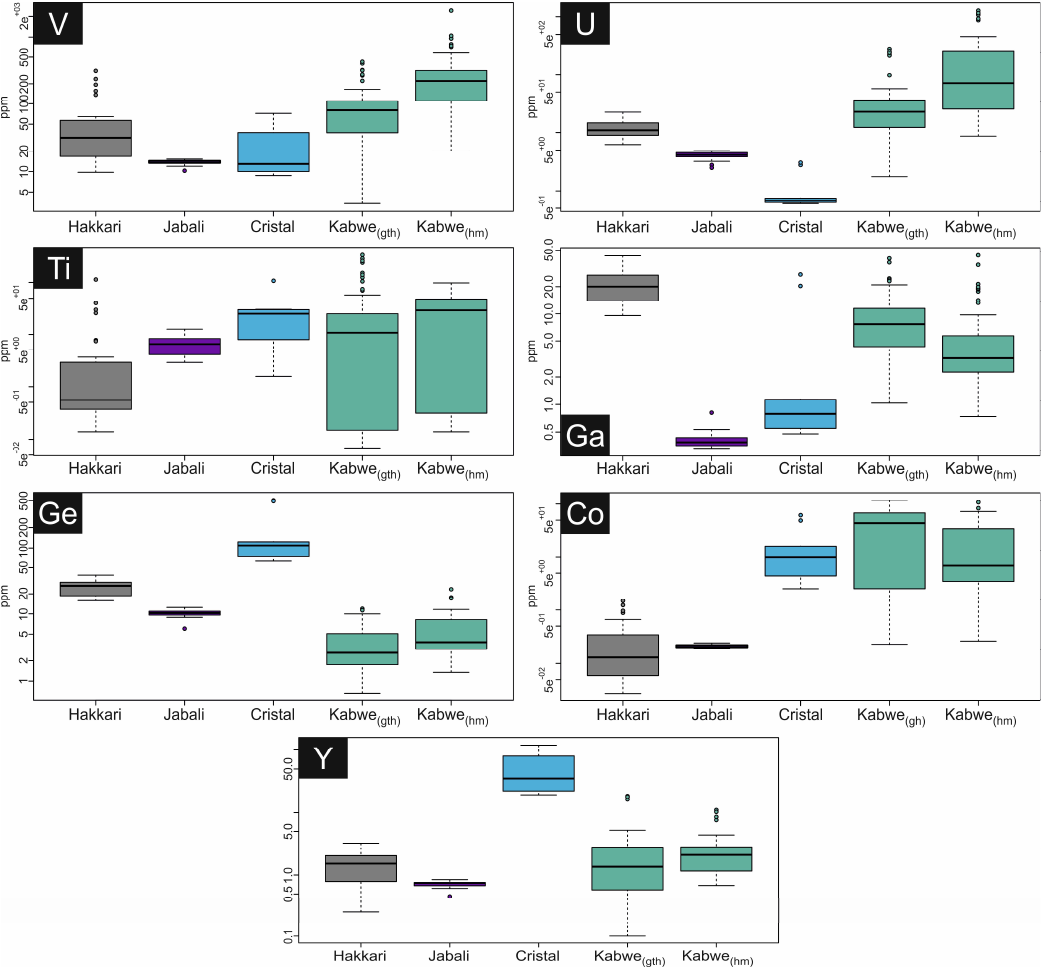
Figure 4. Box and whisker plots showing the chemical composition of the considered FeO/OH from Hakkari and Jabali. Data from Cristal and Kabwe are also reported [18,19]. The Kabwe 1 group consists solely of goethite, occurring in strongly oxidized samples, where Pb-bearing hemimorphite and late-stage Pb-phosphates and Pb(Zn)-vanadates (i.e., pyromorphite and descloizite; Figure 5A) occur as the dominant ore phases (Mondillo et al [19], unpublished data). The Kabwe 2 group consists both of goethite and hematite, which were identified in a sample where sulfides (i.e., sphalerite, galena and pyrite) are directly replaced by willemite and smithsonite. In Kabwe 2, FeO/OH either occur as boxworks or alters pyrite (Figure 5B,C). Hematite and goethite from the Kabwe 3 group form either botryoidal concretions or needle-shaped crystals and occur as late-